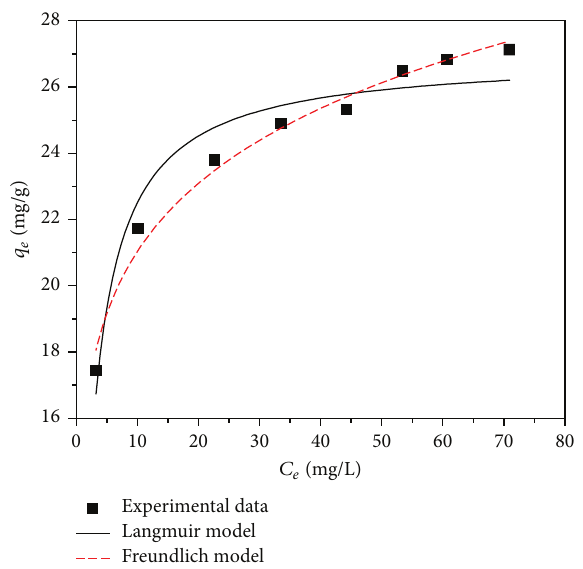
Figure 7: Adsorption isotherm at 298 K and fitted curves of ORII adsorption onto the CTAB-modified cornstalk biochar.